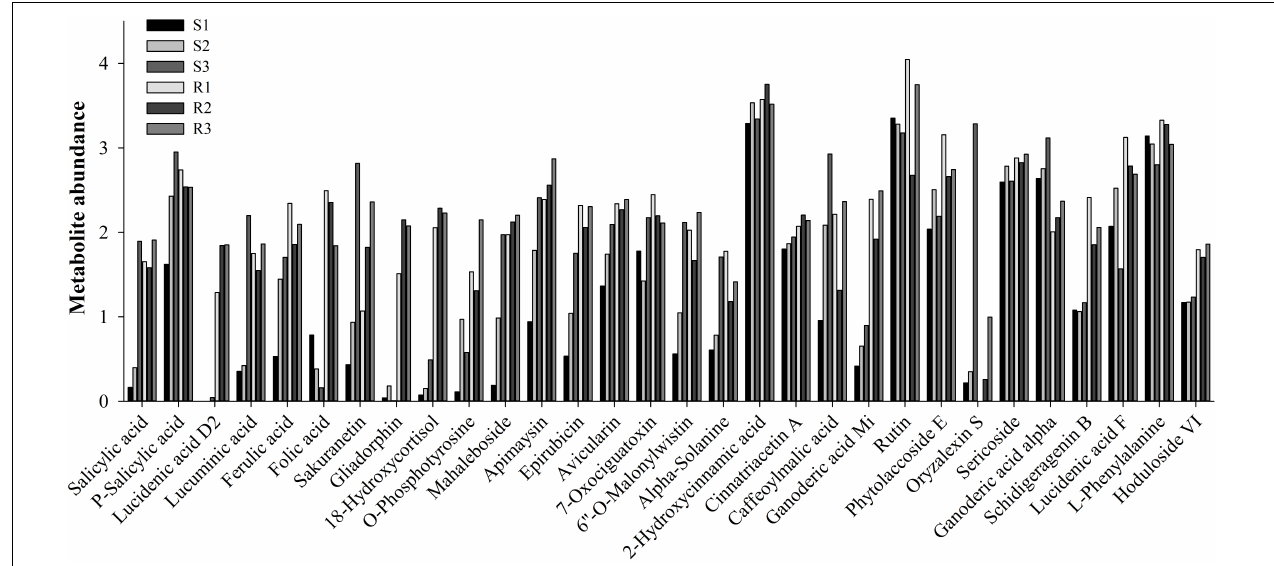
FIGURE 4 | Expression levels of some annotated